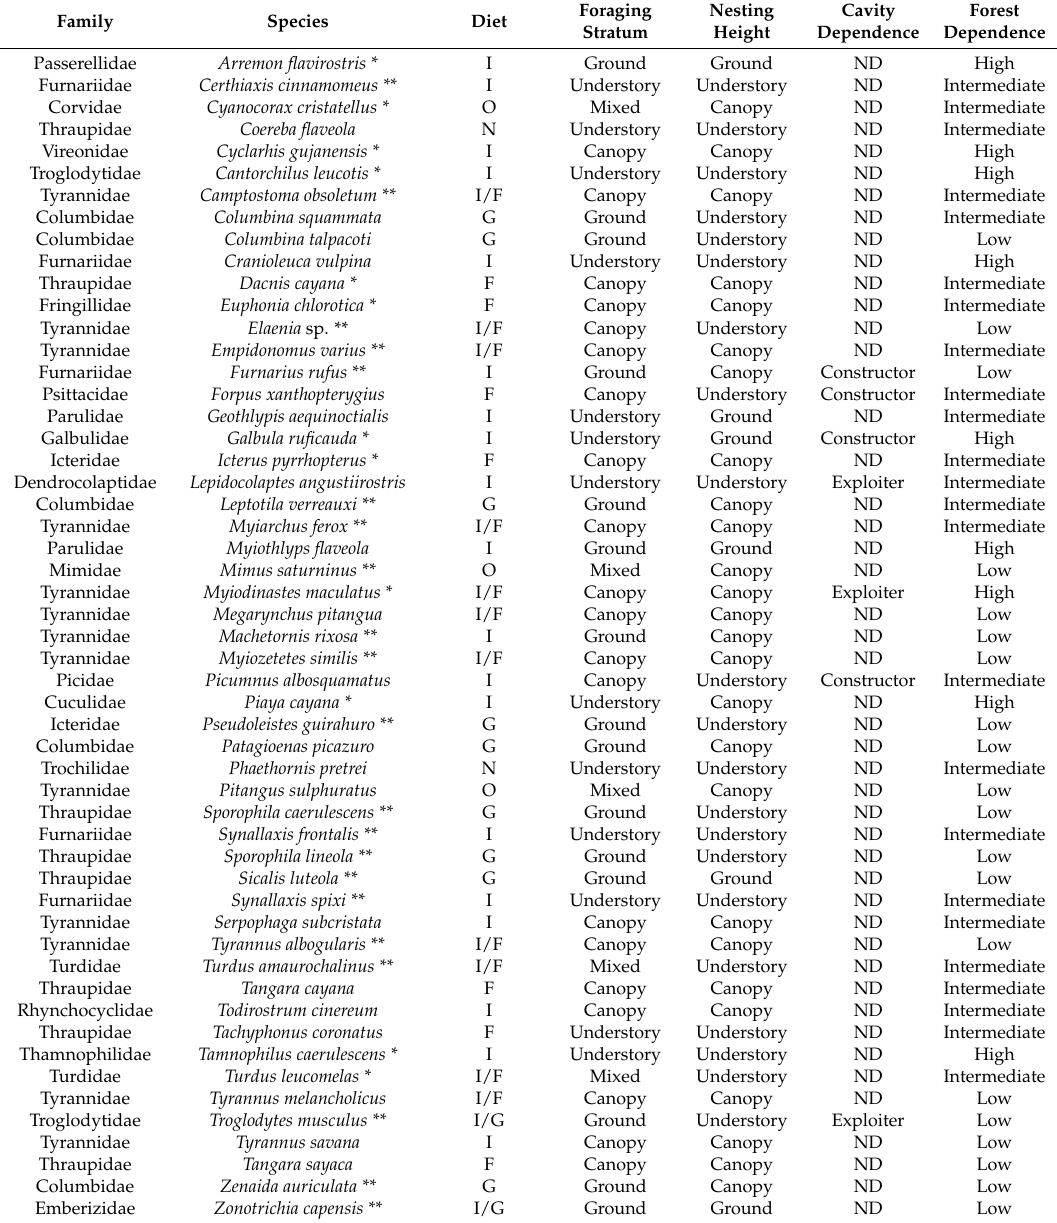
Table A2. Functional traits of bird species recorded in study areas. G = granivore, O = omnivore, I = insectivore, F = frugivore, N = nectarivore, I/F = insectivore and frugivore, I/G = insectivore and granivore, ND = not dependent of cavities. * species recorded only in reference sites. ** species recorded only in sites under